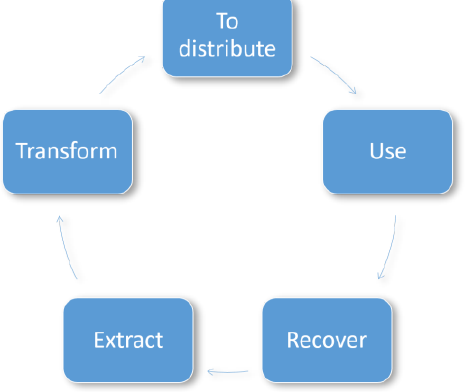
Figure 5. Fields of actions in the circular economy [34].